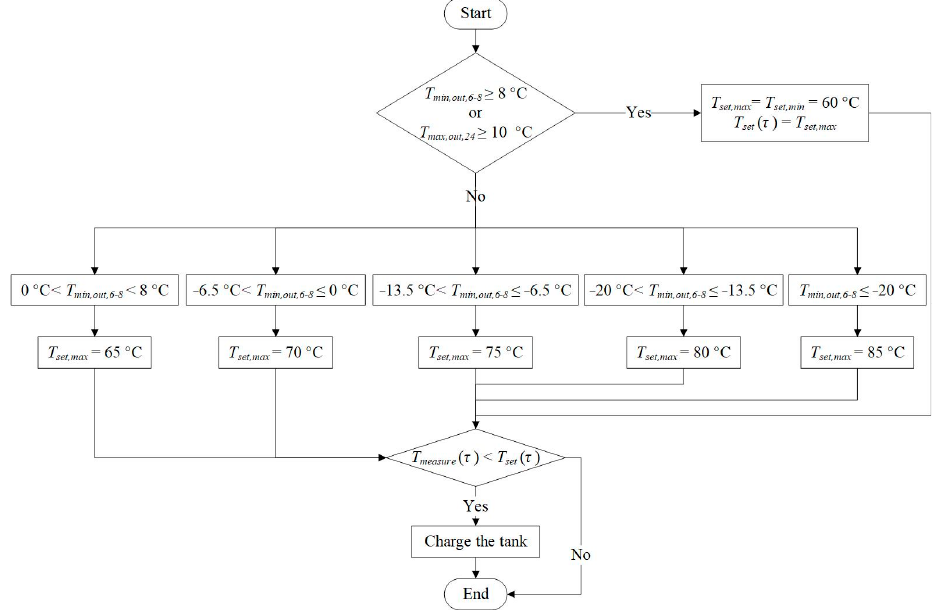
Figure 7. The flowchart of control algorithm for workdays.